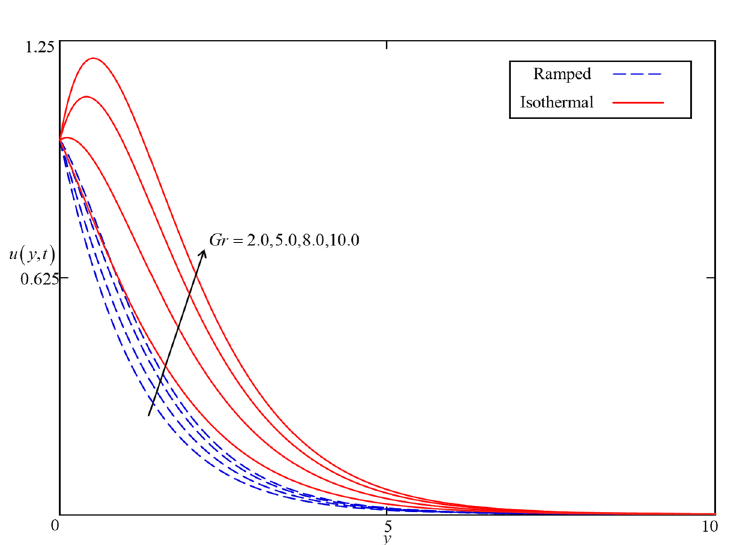
y , t when α = 0.5 , φ = 0.04 , β = 0.5 , Gr = 5 , Nr = 0.5 , and ω t = 0.15 in (cid:31) (cid:30)